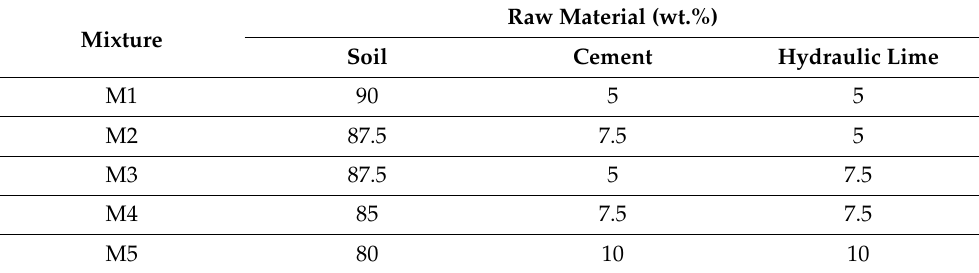
Table 1. Mixtures evaluated in the composition study.